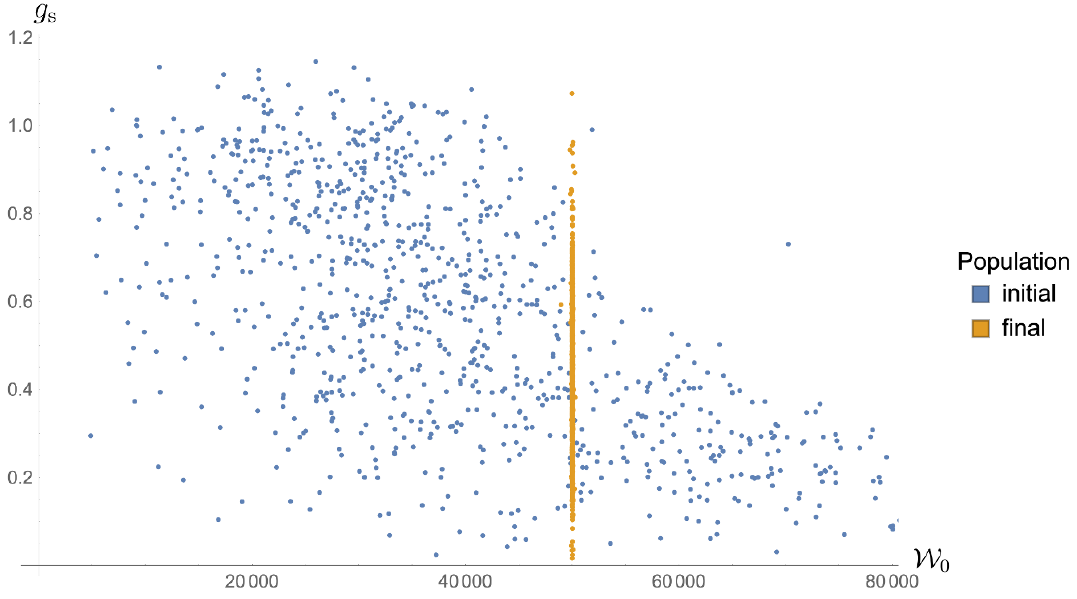
Figure 6 . The distribution for g s and W 0 obtained from a Metropolis